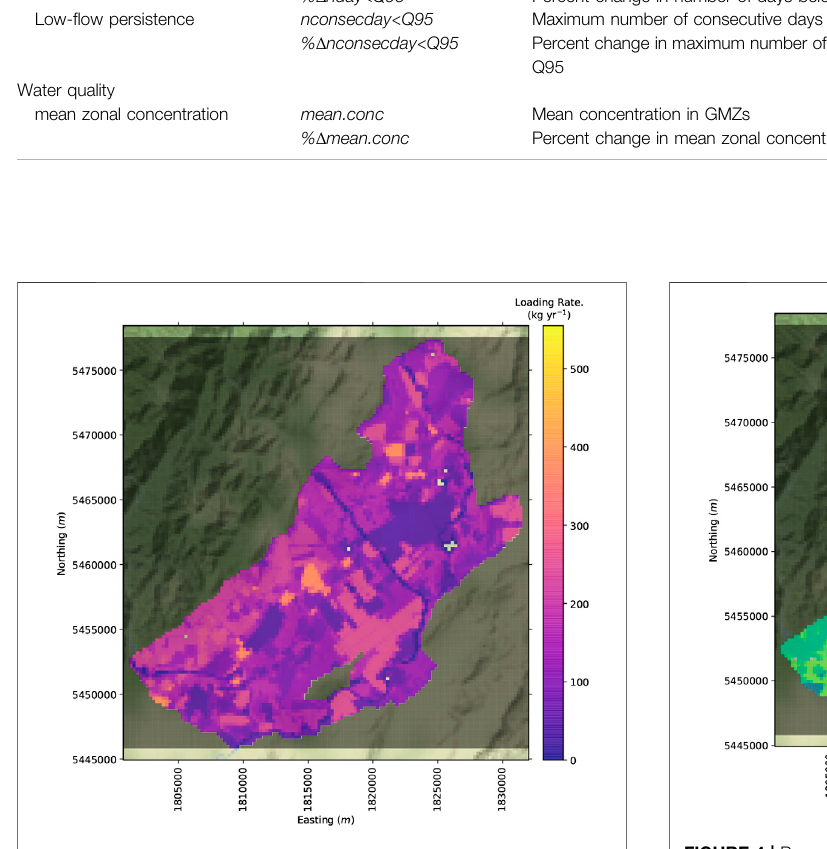
FIGURE 3 | Land-use management scenario nitrate loading rate.